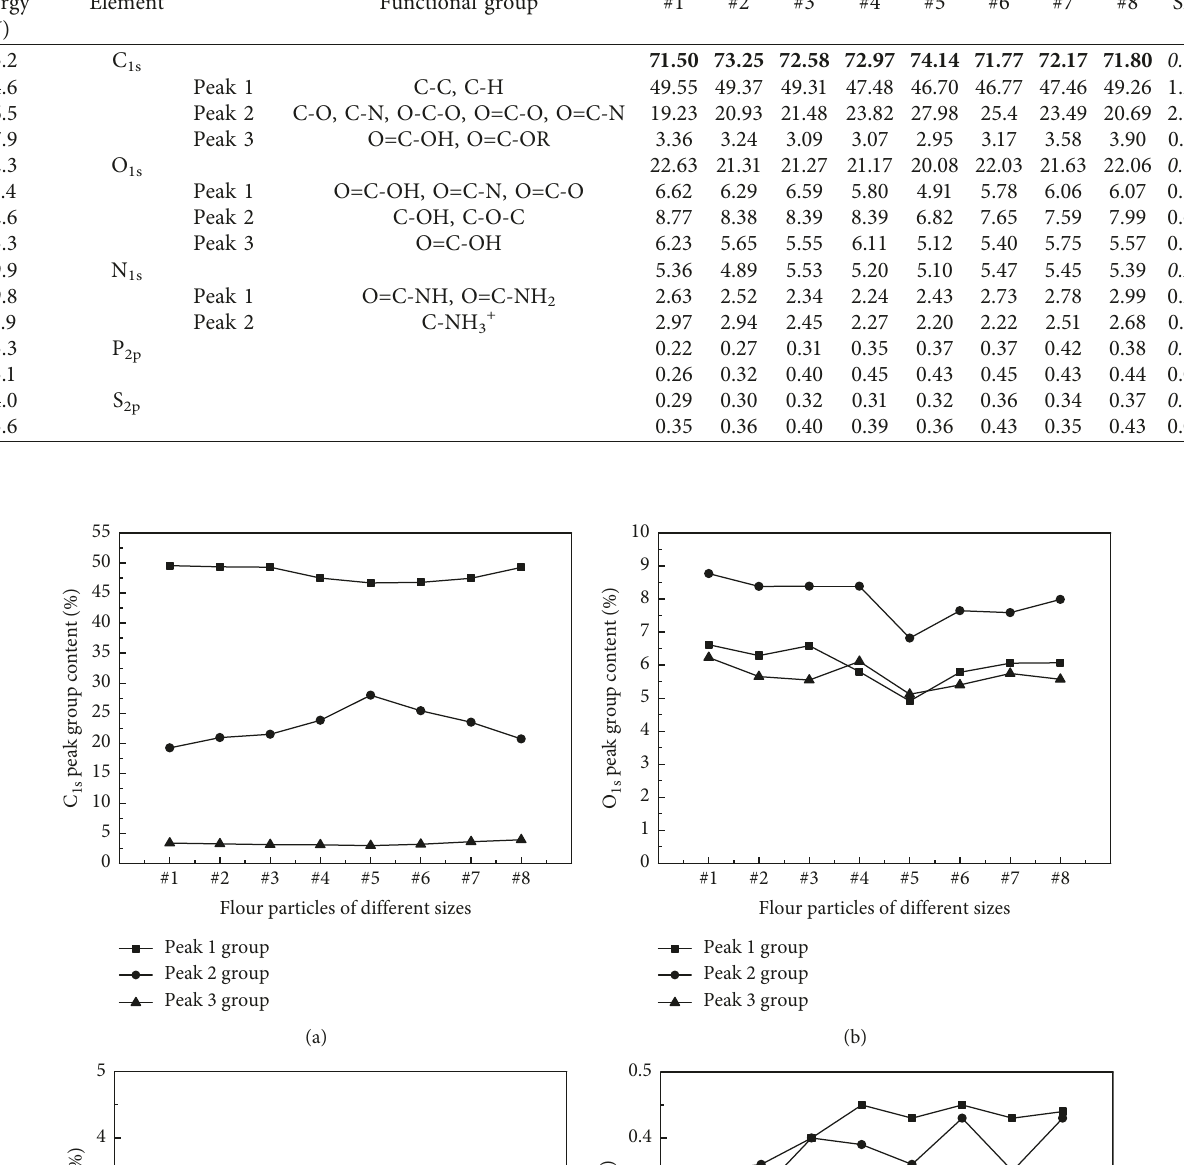
Table 4: The functional group content of C, O, N, P, and S on the surface chemical composition of flour particles of different sizes (%). Binding energy